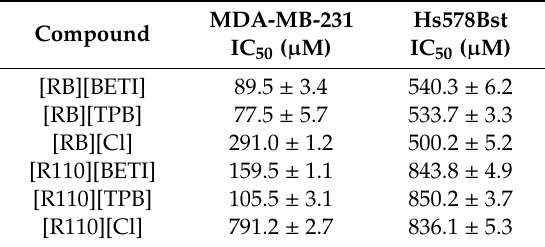
Figure 6. ( a ) Toxicity of R123 nanoGUMBOS towards Hs578Bst normal cells; ( b ) Toxicity of SNAFR-5 nanoGUMBOS towards Hs578Bst normal cells; ( c ) Toxicity of RB GUMBOS toward Hs578Bst normal breast cells; ( d ) Toxicity of R110 GUMBOS toward Hs578Bst normal breast cells. Table 3. IC 50 concentrations of RB and R110 GUMBOS towards MDA-MB-231 cancer and Hs578Bst normal